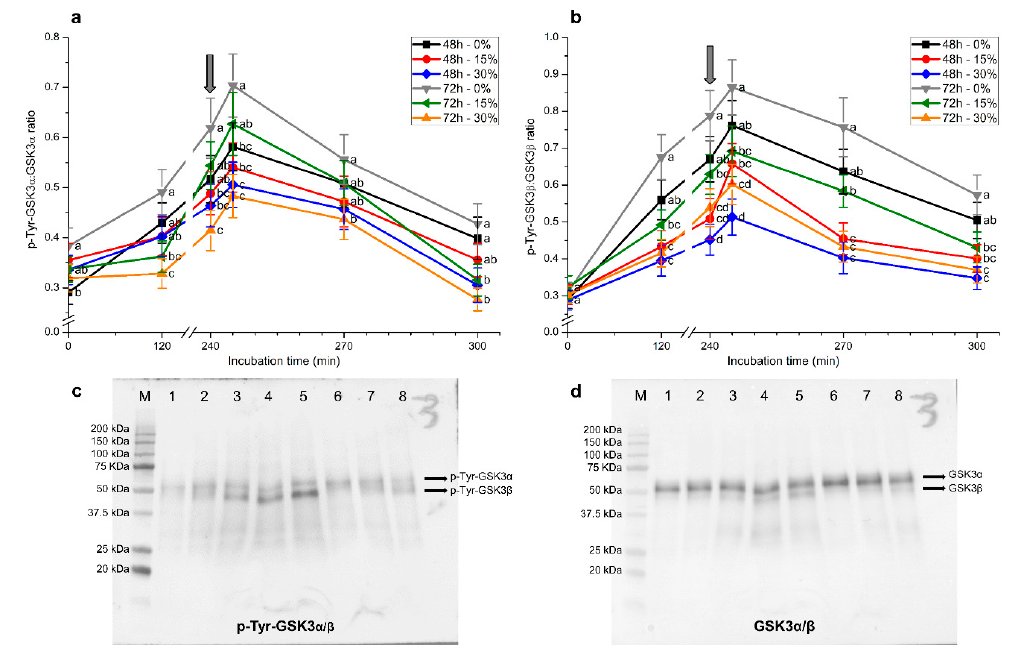
Figure 9. Relative tyrosine phosphorylation levels (using total GSK3 α / β as a loading control) for GSK3 α ( a ) and GSK3 β ( b ) during in vitro capacitation and progesterone-induced acrosomal exocytosis (300 min) after previous storage of spermatozoa at 17 °C with different concentrations of seminal plasma (0%, 15%, and 30%) for 48 h or 72 h. Grey arrow indicates the time at which 10 μ g/mL progesterone was added to induce acrosomal exocytosis (i.e., 240 min). Results are shown as mean ± SEM for seven separate experiments. Different letters mean significant ( p < 0.05) differences between treatments at a given time point. Representative blots for p-Tyr-GSK3 α / β ( c ) and α -tubulin ( d ). Lanes: (M) protein ladder; (1) 72 h, 0% SP, 0 min; (2) 72 h, 0% SP, 120 min; (3) 72 h, 0% SP, 240 min; (4) 72 h, 0% SP, 245 min; (5) 72 h, 0% SP, 270 min; (6) 72 h, 0% SP, 300 min; (7) 72 h, 15% SP, 0 min; (8) 72 h, 15% SP, 120